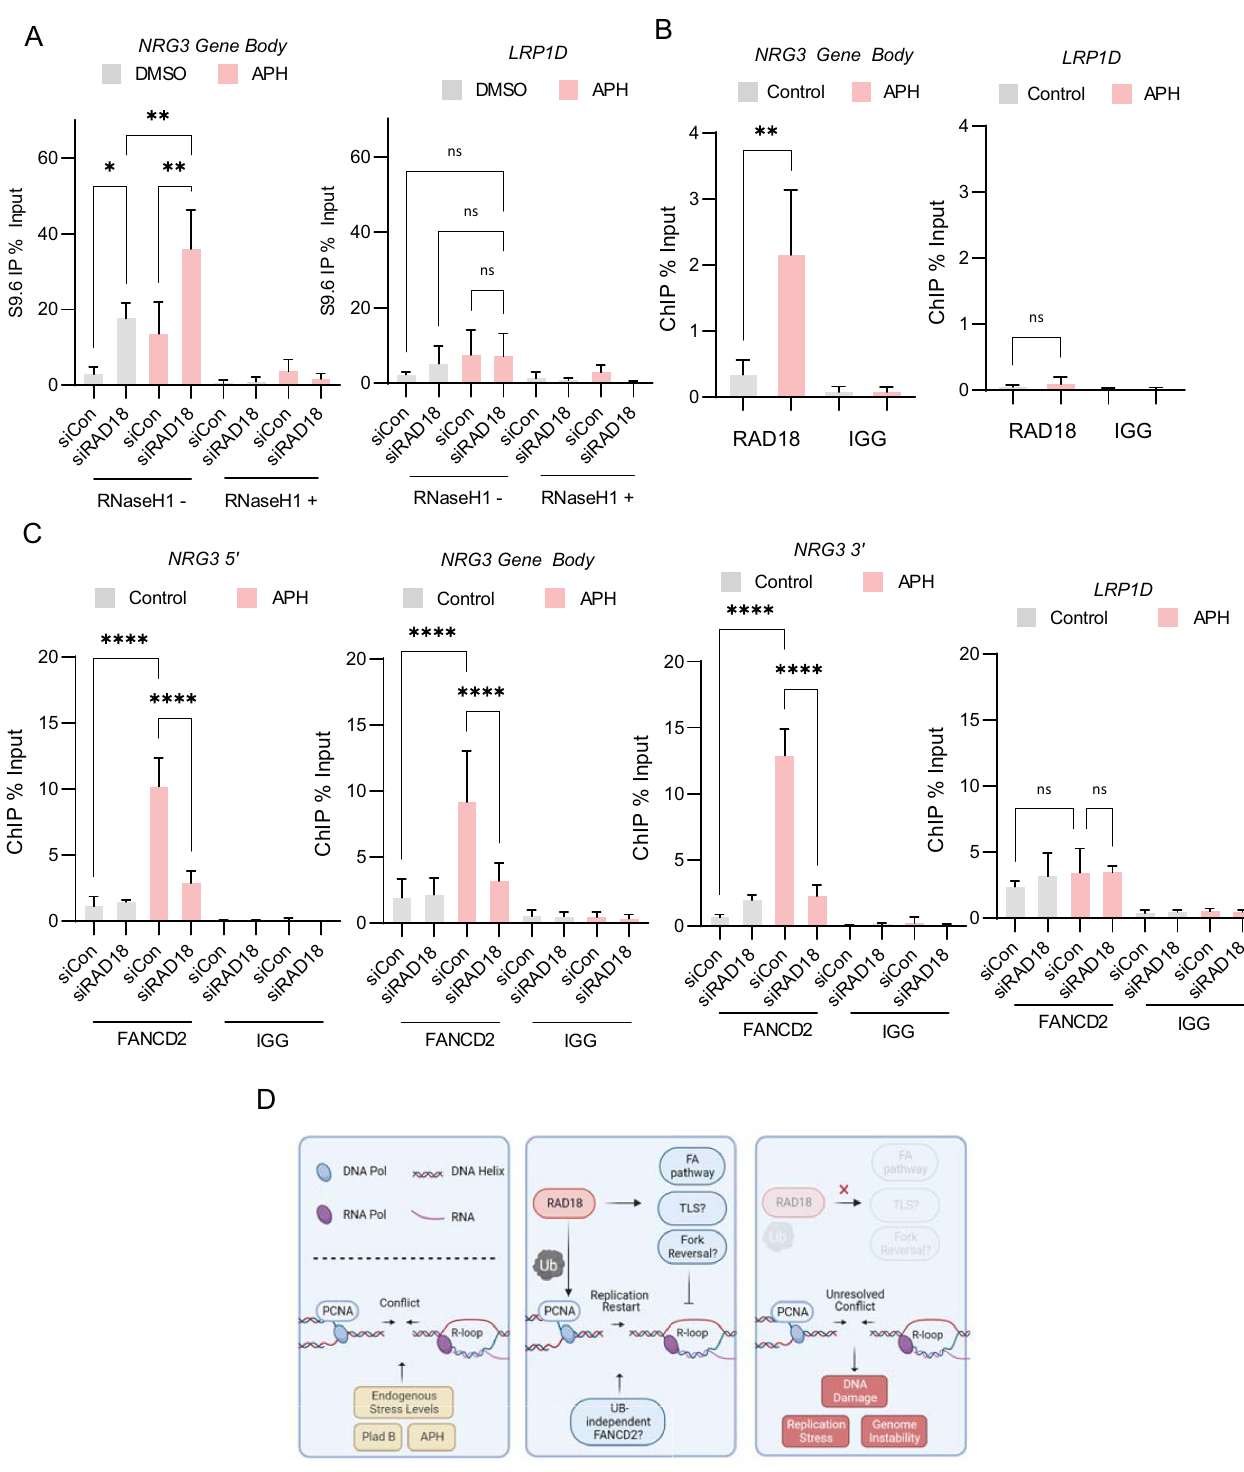
Fig 6. FANCD2 recruitment to Common-Fragile-Sites is dependent on RAD18. (A) DRIP-qPCR in non-targeting control siRNA or siRAD18 treated HeLa cells at the gene body of common fragile site NRG3 and negative control loci LRP1D with either a 24 hour treatment of DMSO or APH and with and without an RNaseH1 treatment at 37˚C for 48 hours. (B) RAD18 ChIP at the gene body of common fragile site NRG3 and negative control loci LRP1D with either a 24 hour treatment of DMSO or APH and IGG ChIP was performed in parallel as a negative control. (C) FANCD2 ChIP in non-targeting control siRNA